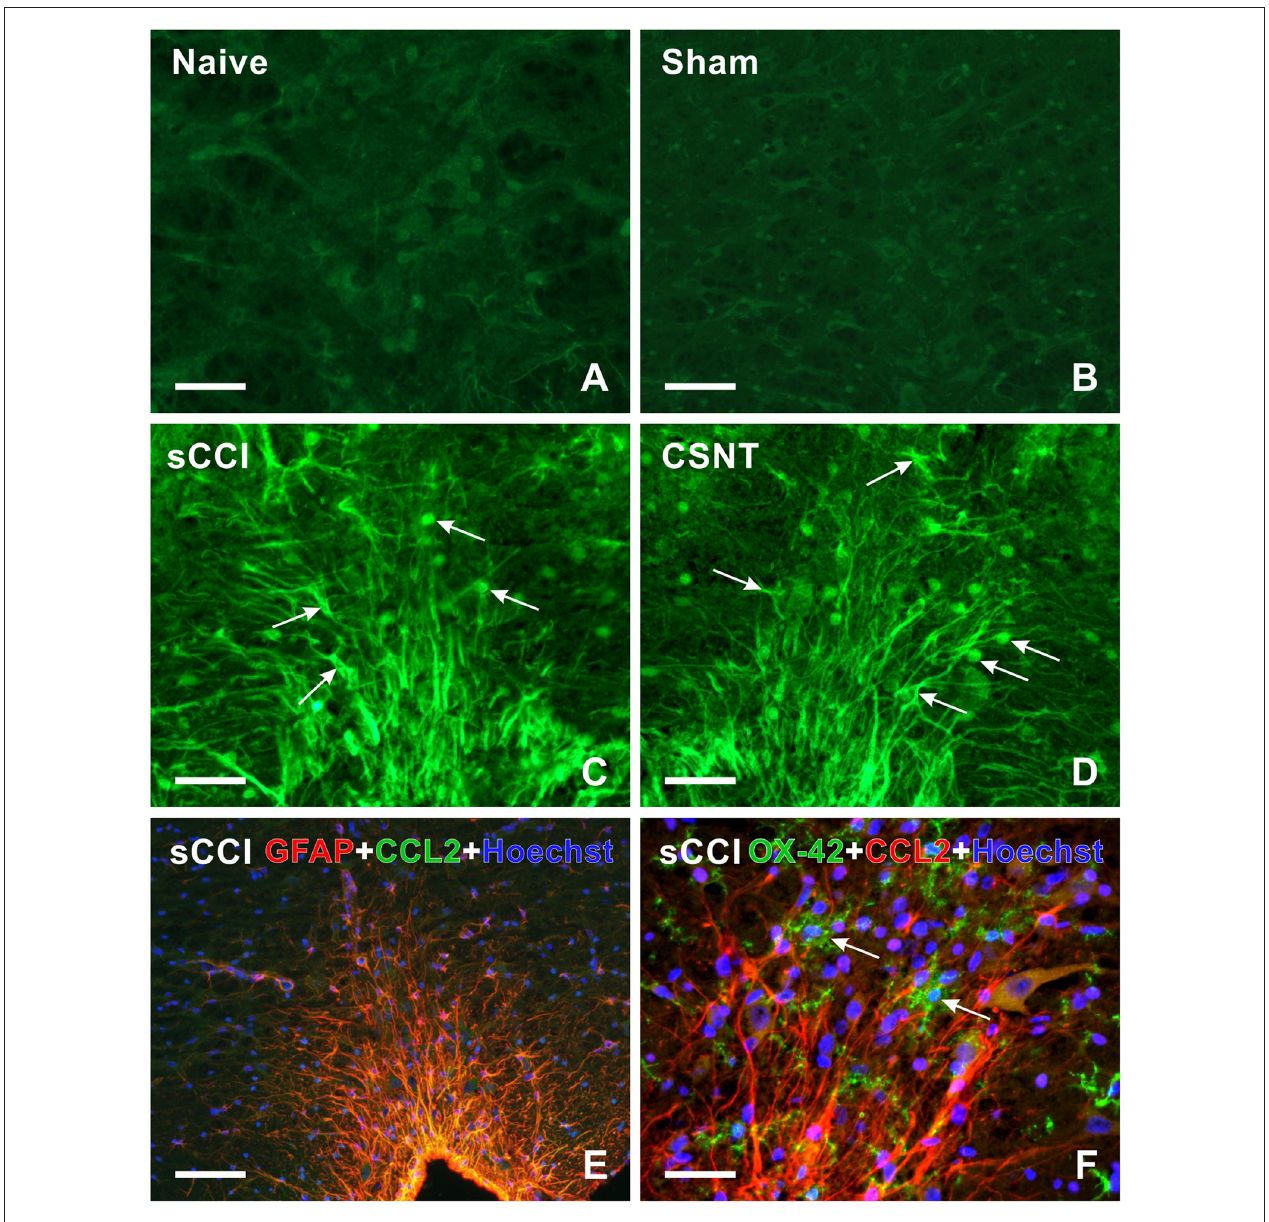
FIGURE 7 | (A–D) Representative medullary sections showing RVM from naïve (A) and sham-operated (B) controls as well as rats 3 weeks from sCCI (C) or CSNT (D) after immunostaining for CCL2. Compared to RVM of naïve and sham-operated rats (A,B) , CCL2 immunofluorescence intensity was significantly increased in cells (arrows) of RVM from rats with injured sciatic nerve (C,D) . (E,F) Representative pictures of double immunofluorescence for GFAP or OX42 and CCL2 in RVM after sCCI of the sciatic nerve for 3 weeks. (E) The section was double immunostained for GFAP (red) and CCL2 (green). The merged picture shows expression of CCL2 protein in all GFAP+ astrocytes of RVM; nuclei (blue) were stained with Hoechst. (F) The section was double immunostained for OX42 (green) and CCL2 (red). The merged picture shows the absence of CCL2 protein in OX42+ microglial cells (arrows); nuclei (blue) were stained with Hoechst. Scale bars = 90 µ m in (B,E) ; 40 µ m in (A,C,D,F)